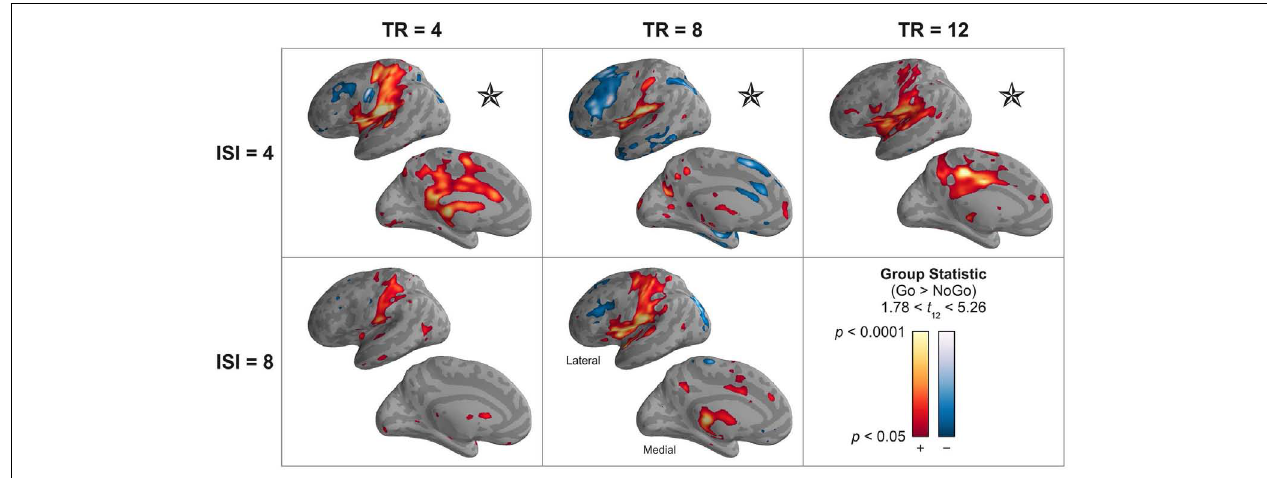
reliably and correctly estimate differential response to these events. Minor FIGURE 11 |A sparse model incorporating convolution of the canonical variations in the pattern of activation across designs may be the result of HRF can distinguish among multiple event types occurring within a differences in the relative efficiency of the presentation order of “Go” and single silent delay. The statistical reliability ( t ) and significance ( p , “No-Go” events rather than specific effects of theTR or ISI.The lateral and uncorrected) of the group effect of the contrast “Go”>“No-Go” events is medial surfaces of the left hemisphere are shown. Supplementary Figure 4 shown.Warm colors correspond to greater activation during “Go” events; (cid:63) provides a volume-based depiction (axial slices) of these data. Supplementary cool colors, “No-Go” events. Stars ( ) indicate those designs in which the Figure 6 illustrates these data for only clusters that survive correction for hemodynamic responses to different event types overlap during a single multiple image volume acquisition (TA), demonstrating the ability of the HRF model to